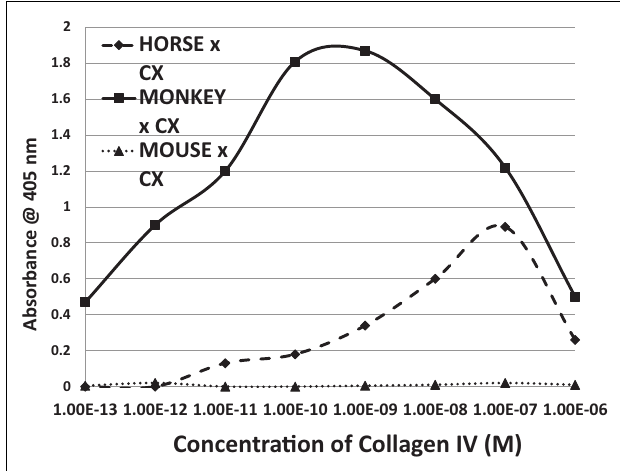
FIGURE 8 | Results of ELISA experiments involving horse anti-coxsackie B4 serum, monkey anti-coxsackie B3 serum, or a monoclonal (MAB) antibody against coxsackie B3 binding to human collagen IV .The downward turn of the curves at high concentrations of collagen IV suggest that collagen IV self-aggregates, hiding the binding sits from antibody. Binding constants for Table 3 were derived from the inflection points of the curves.